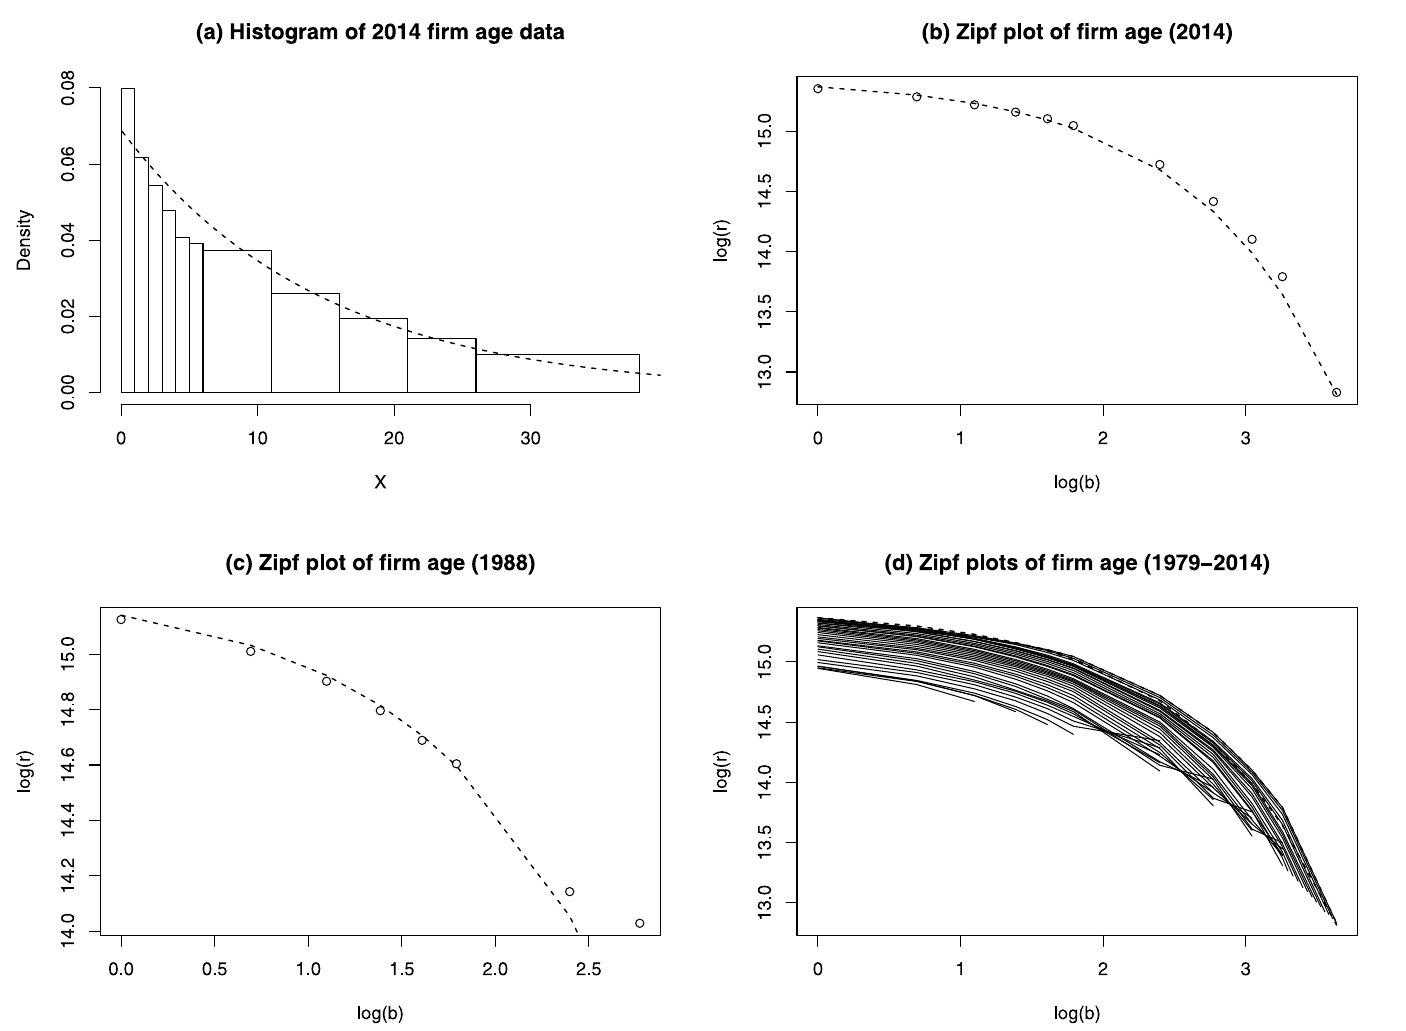
Fig 1. US private-sector firm age data. (a) Histogram of 2014 firm age data. The last class is top-coded and is not shown. The dashed curve shows the fitted exponential density function. (b) Zipf plot of 2014 firm age data (empty dots) and Zipf plot of the fitted exponential distribution (dashed curve). (c) Zipf plot of 1988 firm age data (empty dots) and Zipf plot of the fitted exponential distribution (dashed curve). (d) Zipf plots of firm age data for years from 1977 to 2014. Plot (a) of Fig 1 shows the histogram of the 2014 US firm age data.